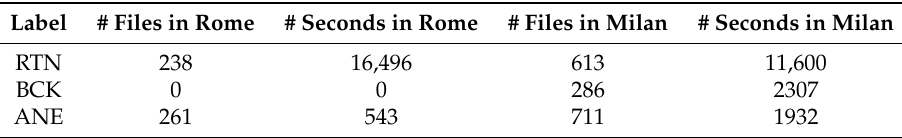
Table 1. Summary of the labels distribution and total durations of recorded audio databases for both urban and suburban scenarios (Rome and